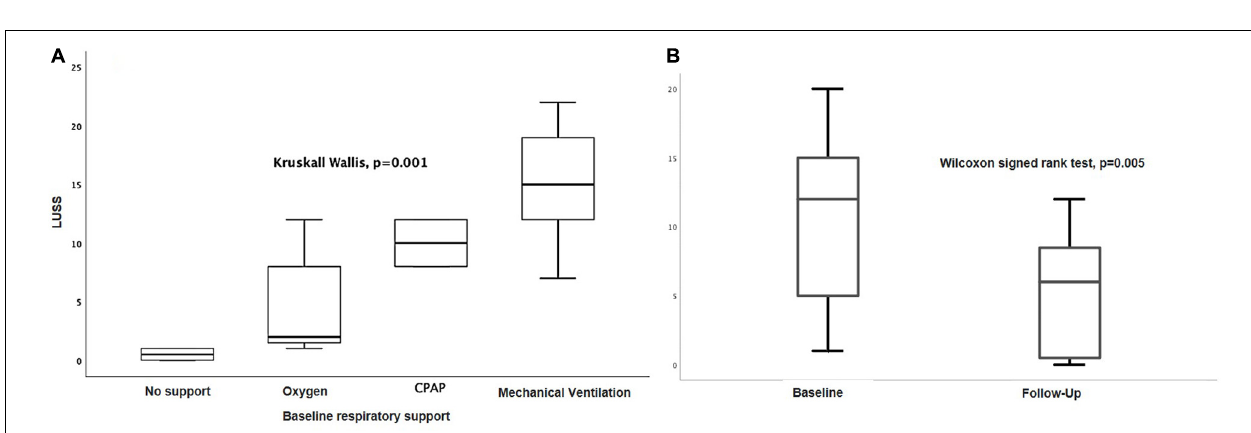
FIGURE 2 | LUS abnormalities and its corresponding radiography are shown. Abnormal patterns found were B-line interstitial pattern 90% (A) , irregular/interrupted/thick pleural line 88% (B) , compact B-lines 65% (C,D) , small consolidations ( ≤ 5 mm) 34% (E) , and extensive consolidations ( ≥ 5 mm) 37% (F) .